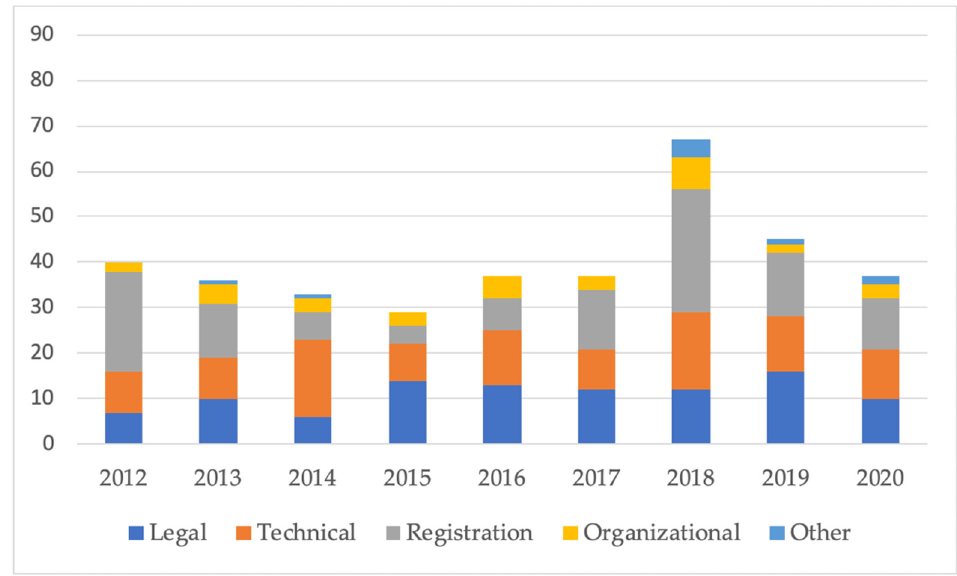
Figure 5. Distribution of publications in the secondary categories 2012–2020.